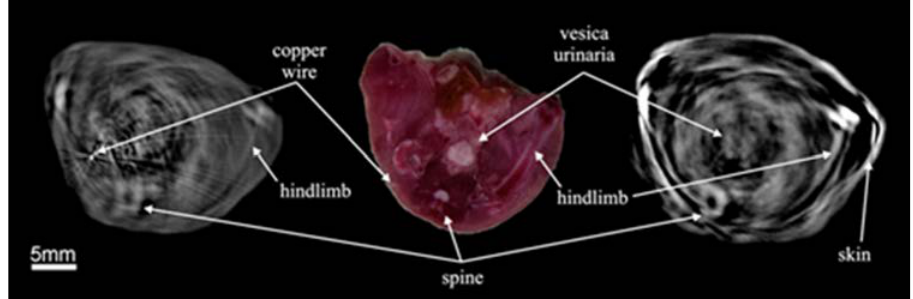
Fig. 13. Mouse imaging experiments ex vivo . (a) Cross-sectional TAI acquired from an intact mouse inserted with a 230 (cid:5) m diameter copper wire. (b) The histological slice of the mouse made at approximately the same level. (c) The similar TAI acquired from the mouse without the presence of the copper wire. 35